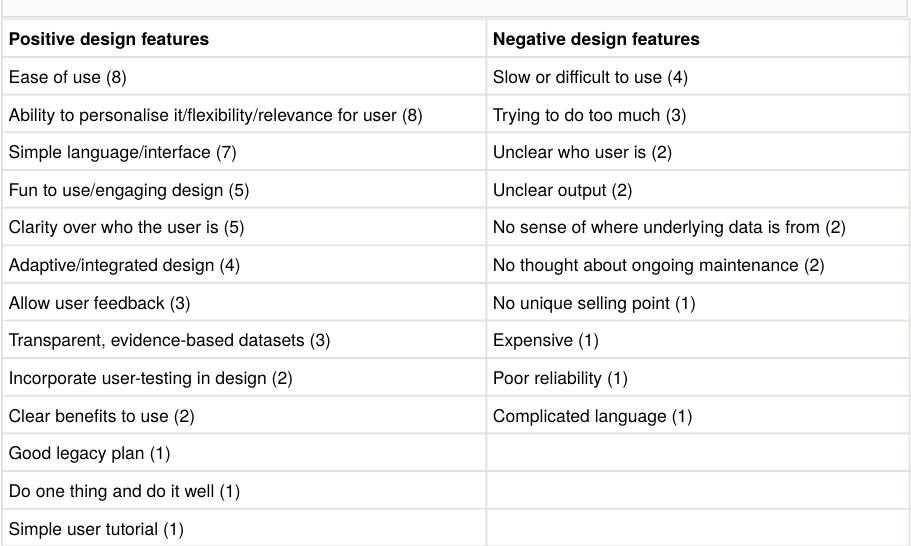
Good and bad design features as described by delegates (number in brackets determines no. of